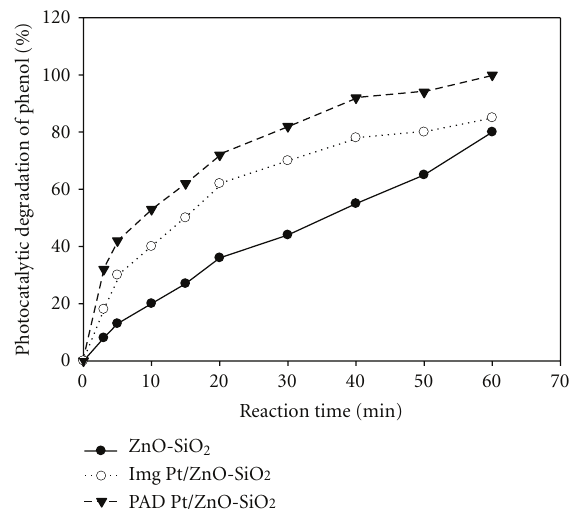
Figure 8: Photocatalytic degradation of phenol (%) for ZnO-SiO 2 , Img: Pt-ZnO-SiO 2 , and PAD: Pt-ZnO-SiO 2 . (a) PAD: Pt-ZnO-SiO 2 , (b) Img: Pt-ZnO-SiO 2 , and (c) ZnO-SiO 2 .